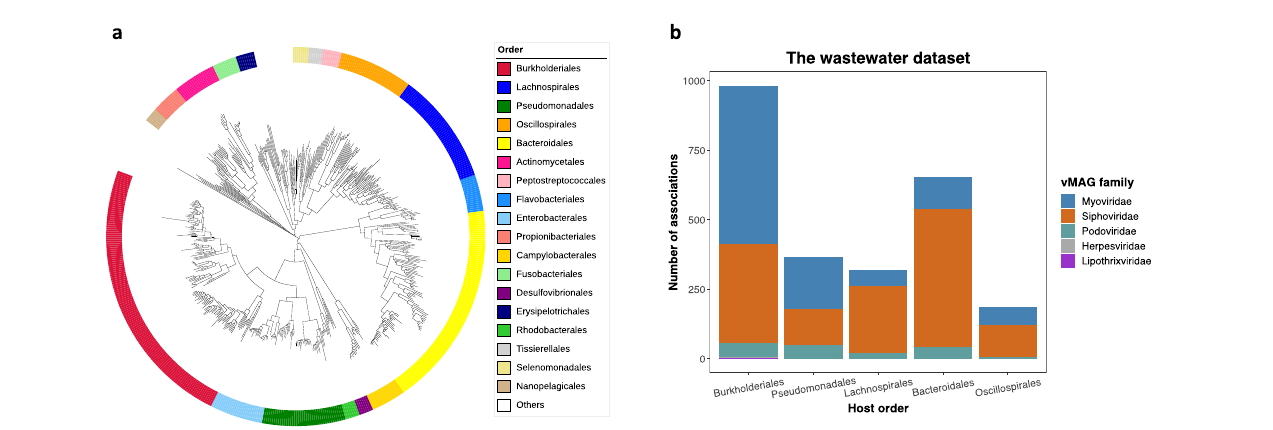
wastewater sample. vMAGs belonging to the family Myoviridae mainly targeted hostsfromtheorder Burkholderiales andalargenumberofvMAGsfromthefamily Siphoviridae could infect Bacteroidales bacteria. Source data are provided as a Source Data fi